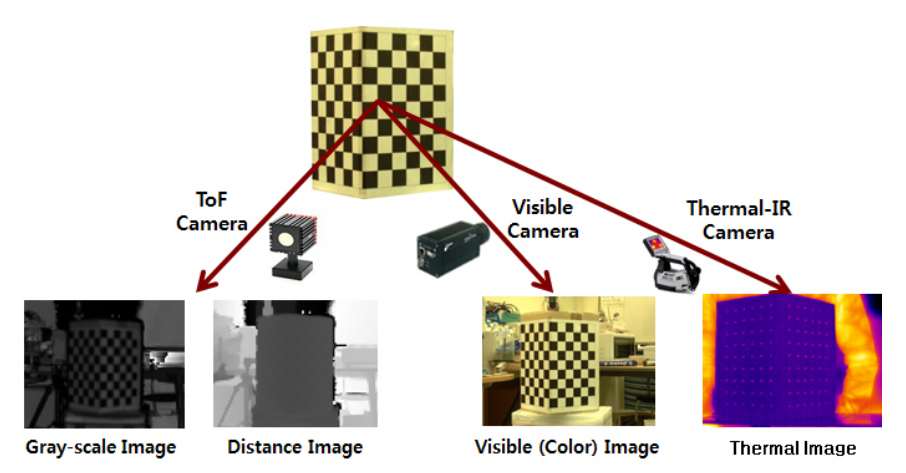
Figure 1. Proposed system comprising ToF, visible and thermal-IR